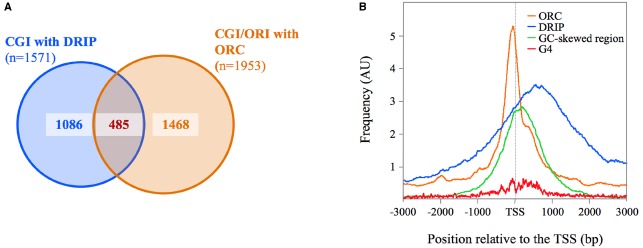
Association between R-loops and ORC1-binding sites at CpG island-origins in human cells. (A) Venn diagrams illustrating the association between R-loops (defined as consensus DRIP peaks in Ginno et al., 2013) and ORC1-binding sites at origin regions (defined by intersecting ORC1 binding sites from Dellino et al., 2013 with SNS-Seq data from Besnard et al., 2012) at CpG island promoters in human cells (UCSC database hg19). See text for details. Alignment of the DRIP-Seq or SNS-Seq reads to the hg19 build was carried out using BWA (Li and Durbin, 2009), and peak calling was done using MACSv2 (Zhang et al., 2008). For DRIP-seq, peaks were called using all mapped reads, enforcing a greater than fivefold enrichment above input as described (Ginno et al., 2012). (B) Distribution of ORC1-binding sites (orange lines), DRIP peaks (blue lines) and G4 motifs (red lines) at the CpG-island origin set defined in (A). Composite profiles were generated by plotting hits per base over 6 kb for 485 CpG island regions centered at their TSS (defined as the 5′-end of RefSeq genes) normalized by the total hits over the whole genome. G4 positions were determined applying Quadparser on hg19 and specifying a loop size of 1–7 nucleotides between 4 tracks of GGG or CCC (Huppert and Balasubramanian, 2005). The green line represents the localization of the GC-skewed region of the analyzed CpG islands from Ginno et al. (2012).